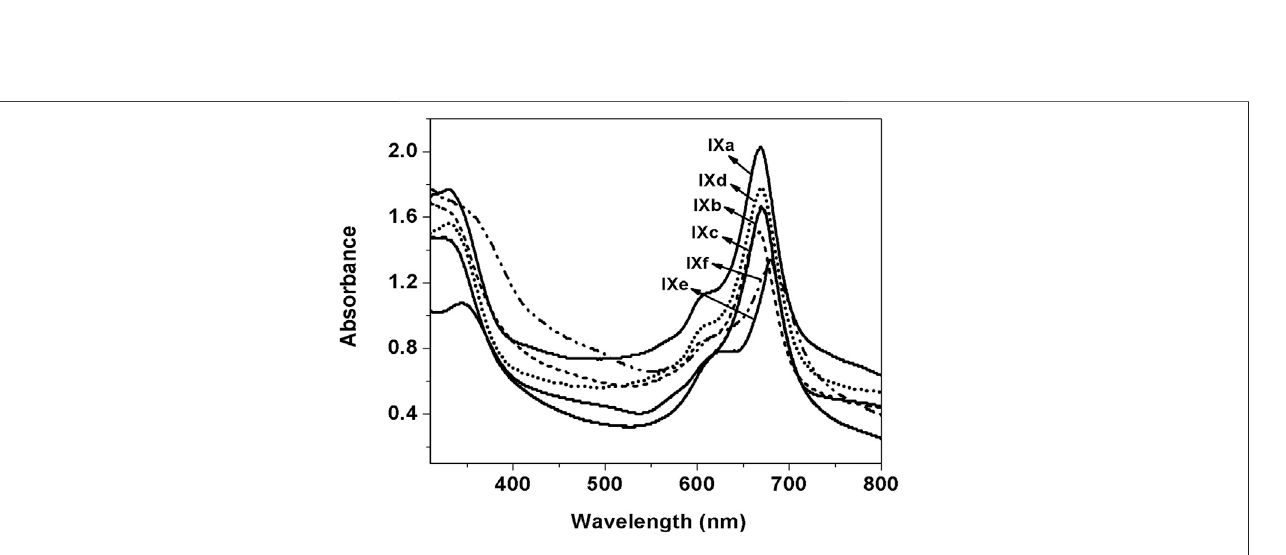
FIGURE 2 | UV – visible spectra of ( IXa – f ) in DMSO.